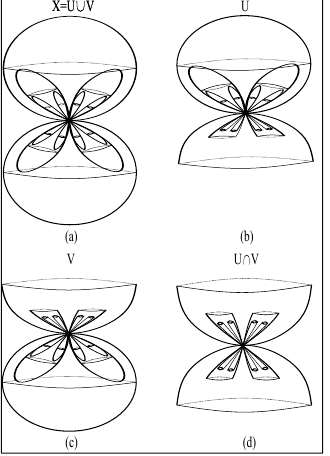
Figure A5. Open sets U and V for computing the cohomology group H 2 ( X )